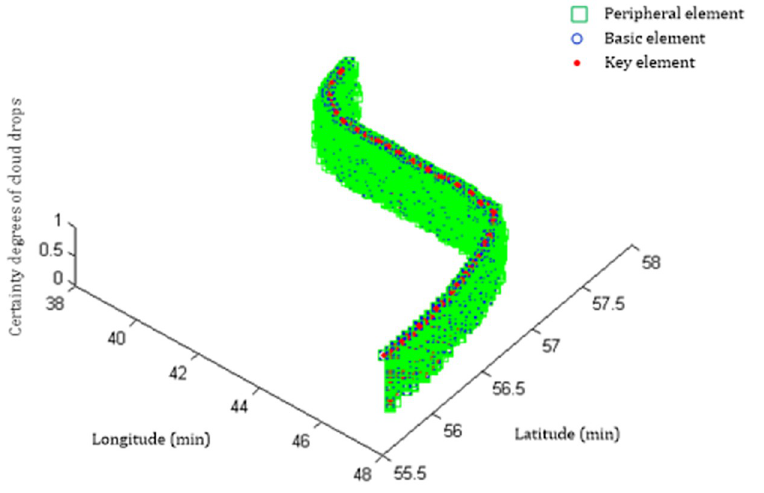
Fig 8. The comparison chart of the three track